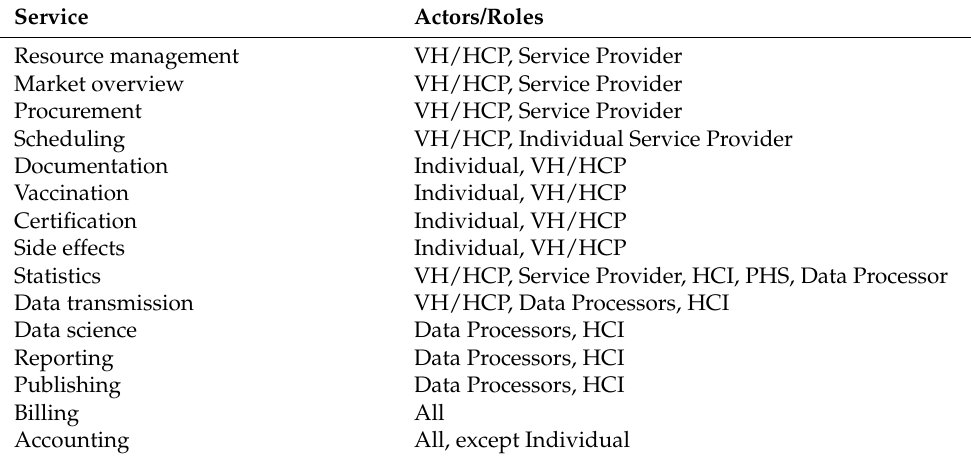
Table 1. List of specialized services and involved